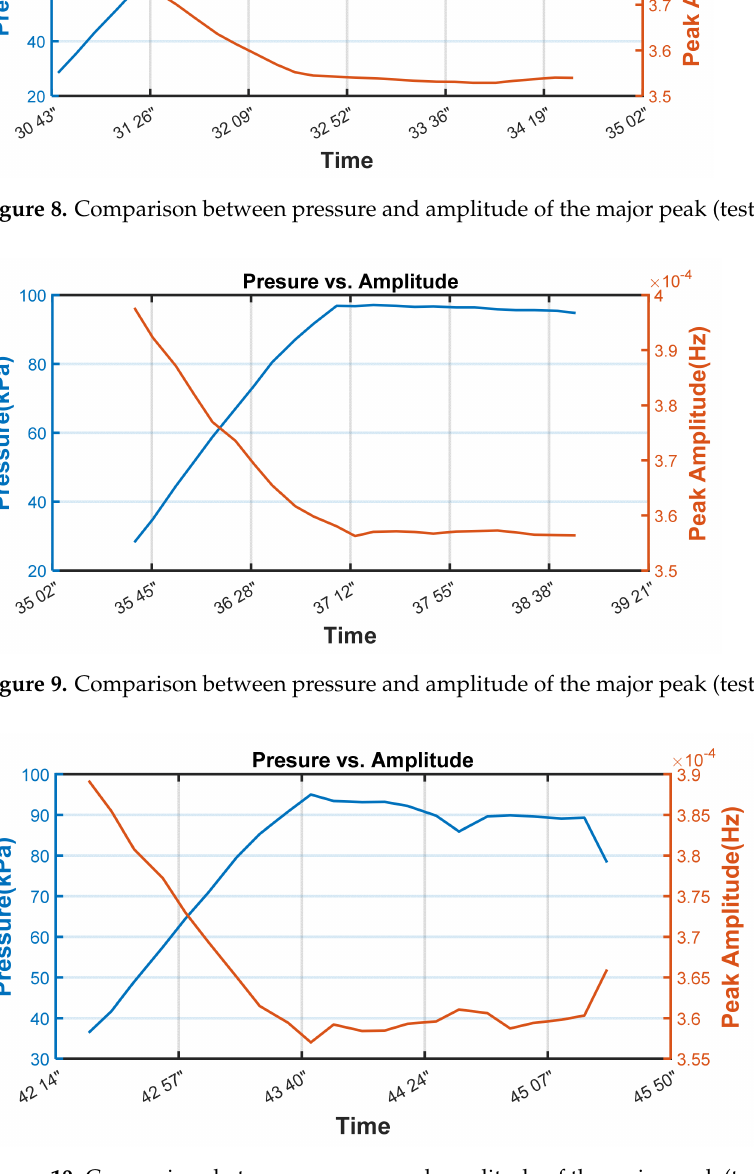
Figure 10. Comparison between pressure and amplitude of the major peak (test